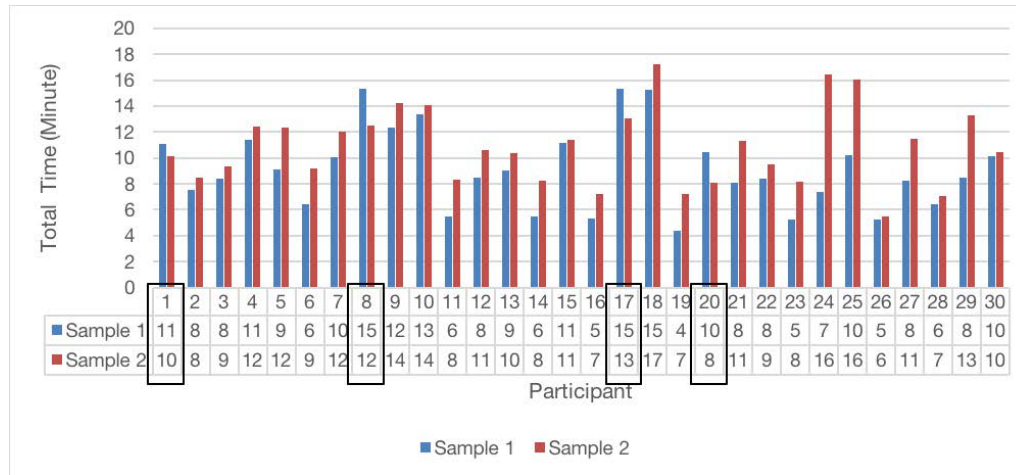
Figure 7. The time for each participant to find answers for all tasks by using di ff erent samples. Only four participants which are marked by a black box spent a longer time on sample 1 than sample